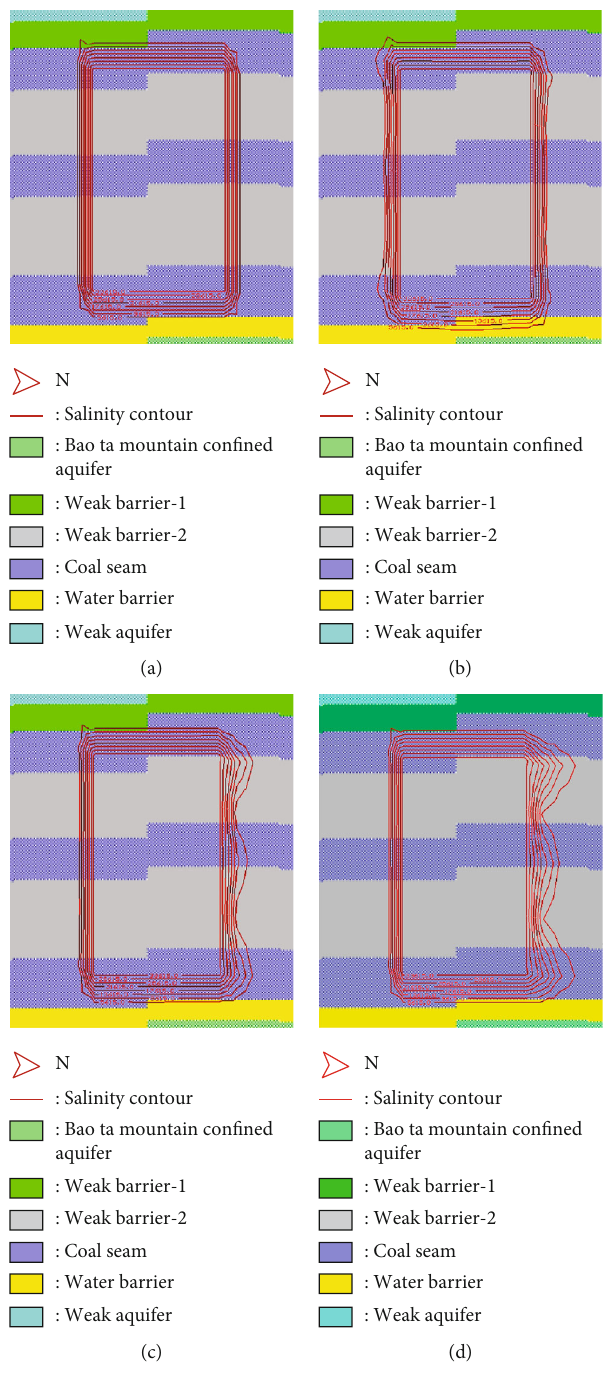
Figure 9: The migration of concentrated brine to the north side under di ff erent groundwater head di ff erences after long-term penetration for 50 years (the model is stretched 20 times the actual vertical direction, (a) is the initial state, (b) is 10 meters, (c) is 50 meters, and (d) is 100